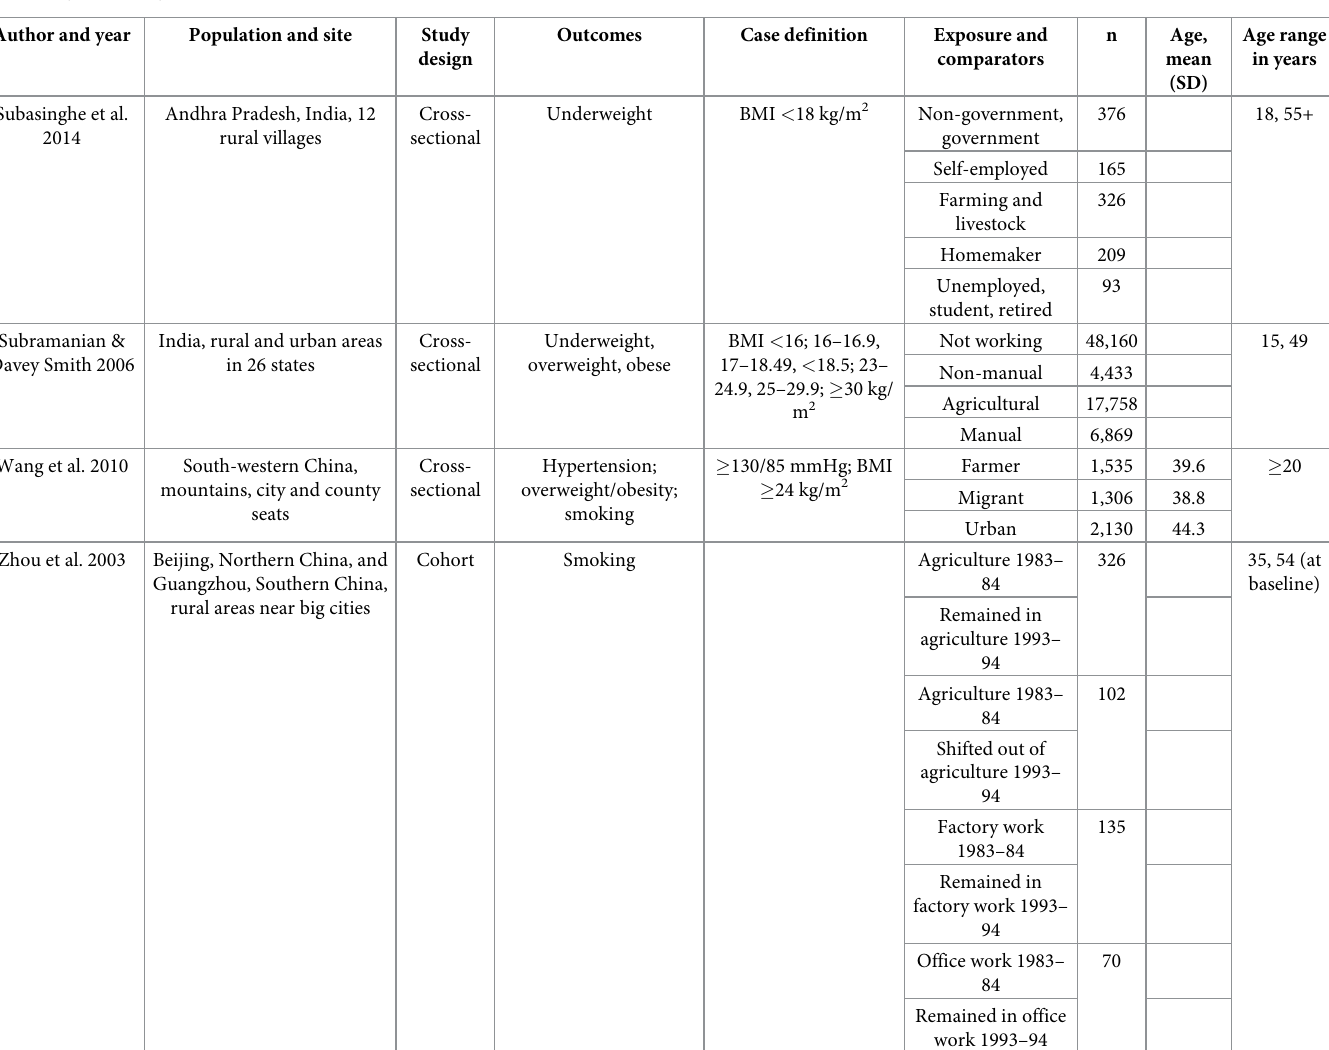
Hypertension. Nine studies reported sufficient data for calculating PRs (95% CIs)